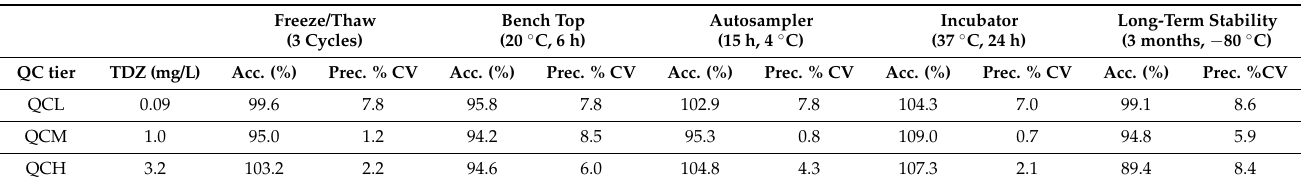
Table 2. Stability study of TZD under different experimental conditions in MHB bacterial growth media ( n = 3, per QC tier in each condition) with accuracy (Acc.) and precision (Prec.).